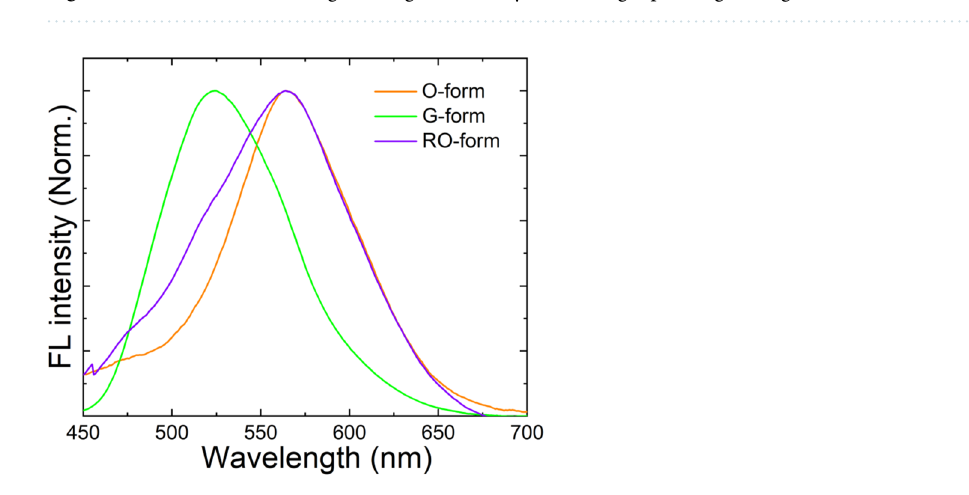
Figure 3. FL emission wavelength change of DSP crystals during repeated grinding and UV-irradiation cycles.